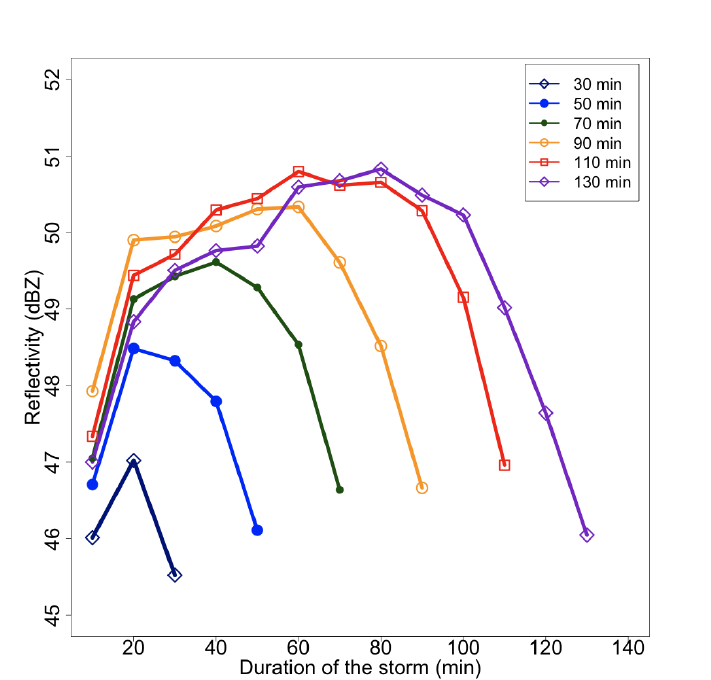
Figure 3. Reflectivity maxima averaged in each instant of the cell development for several track